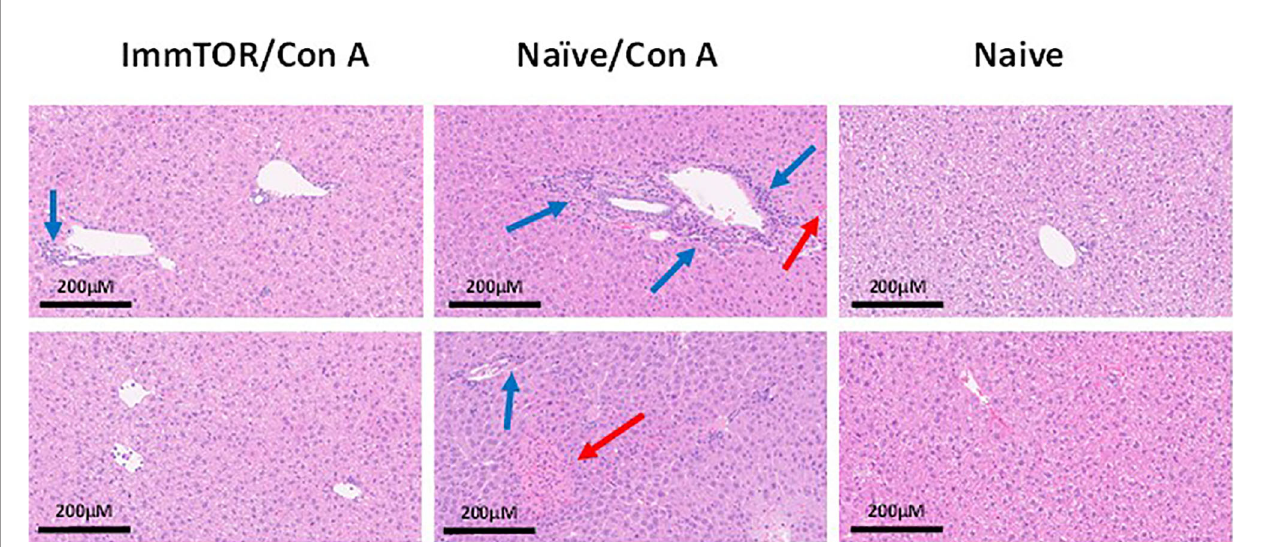
FIGURE 10 | ImmTOR pretreatment diminishes hepatic cytotoxicity after Con A challenge. Mice which were either untreated or pre-injected with ImmTOR particles (300 µg) were challenged with concanavalin A (12 mg/kg, i.v.), sacri fi ced 24 hours later, livers fi xed and processed to tissue slides, stained by hematoxylin-eosin, and analyzed microscopically. The areas of leukocyte in fi ltration adjacent to vessels (blue arrows) and necrotic areas (red arrows) are indicated. Samples from two representative animals are shown for both groups vs. naïve controls (no treatment, no Con A) as